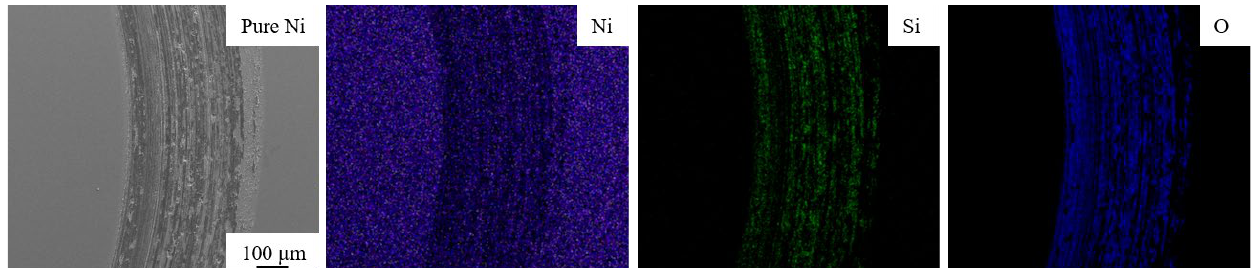
Figure 7. Energy dispersive spectroscopy (EDS) maps of wear track on pure Ni.